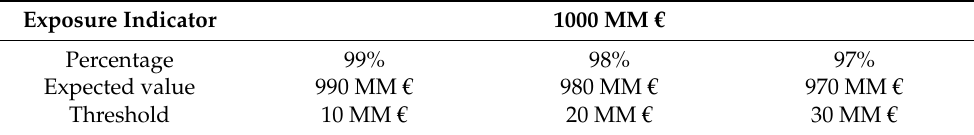
Table 2. Example of Thresholds based on